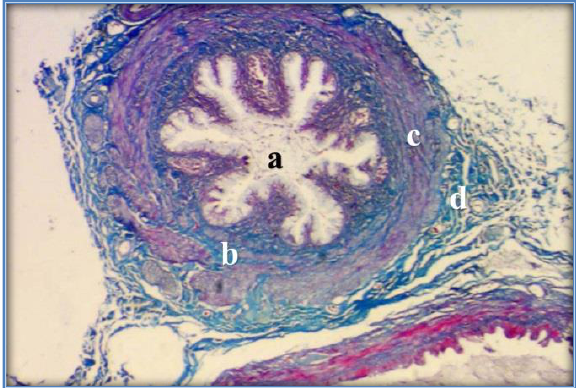
Figure,5: Histological section of ductus deferens: a- lumen, b- sub mucosa, c- tunica muscularis d- adventitia. Masson´s Trichrome stain (40x).